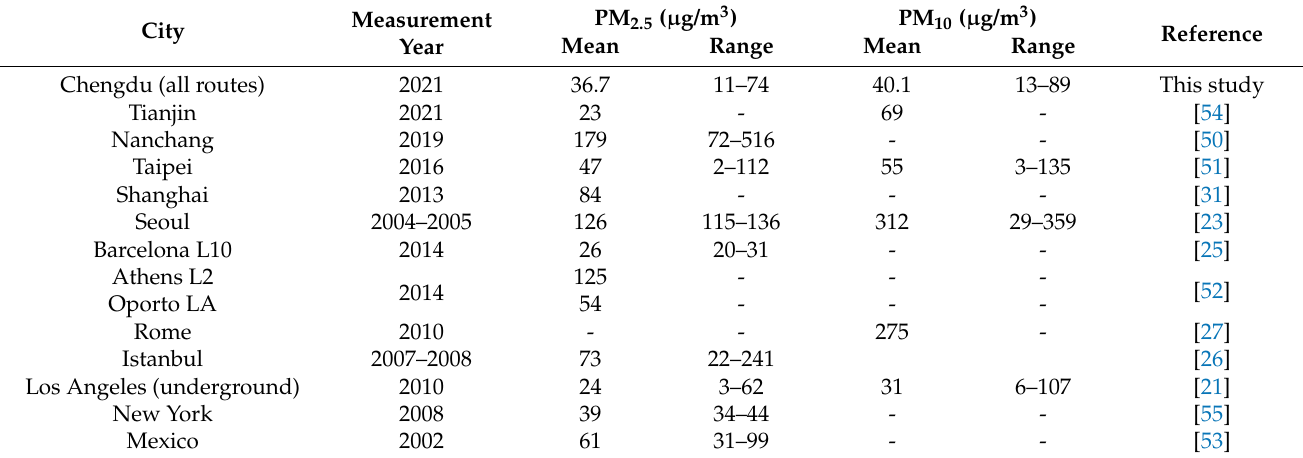
Table 1. Average PM 2.5 and PM 10 concentrations in metro carriages